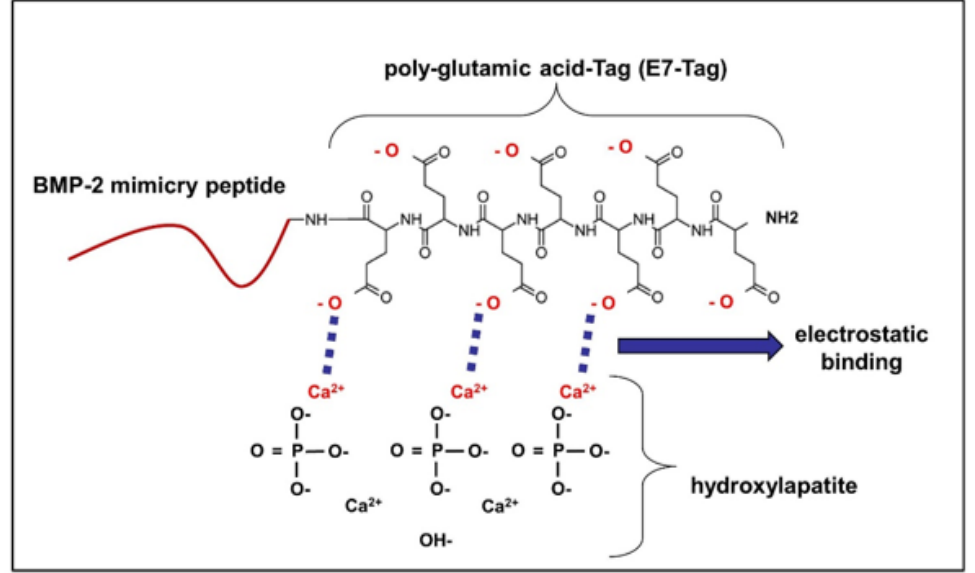
Figure 2. Principle of electrostatic binding of BMP-2 mimicry peptides to HA. BMP-2 mimicry peptides bind through their negative charges to the positively charged Ca ions of hydroxyapatite (HA). E7 BMP-2 peptides contain additionally a poly-glutamic acid residue conferring them the possibility to strongly bind electrostatically to HA on this site.